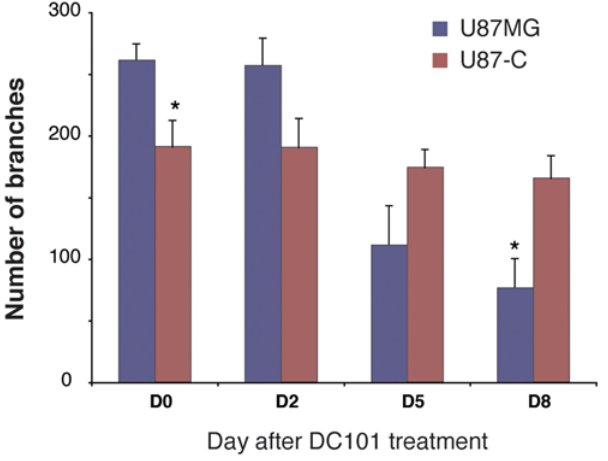
Figure 5. PDGF-C attenuates the response to VEGFR2 block- ade. U87MG or U87-C tumor-bearing mice were treated with DC101 antibody (40 mg/kg) when their tumors reached 2 mm in diameter. Intravenous injections of DC101 were performed on days 0, 3 and 6. Vessels in the parental U87MG tumors are pruned in response to DC101 (fewer branch points). In contrast, U87-C tumors showed no response (n=6).